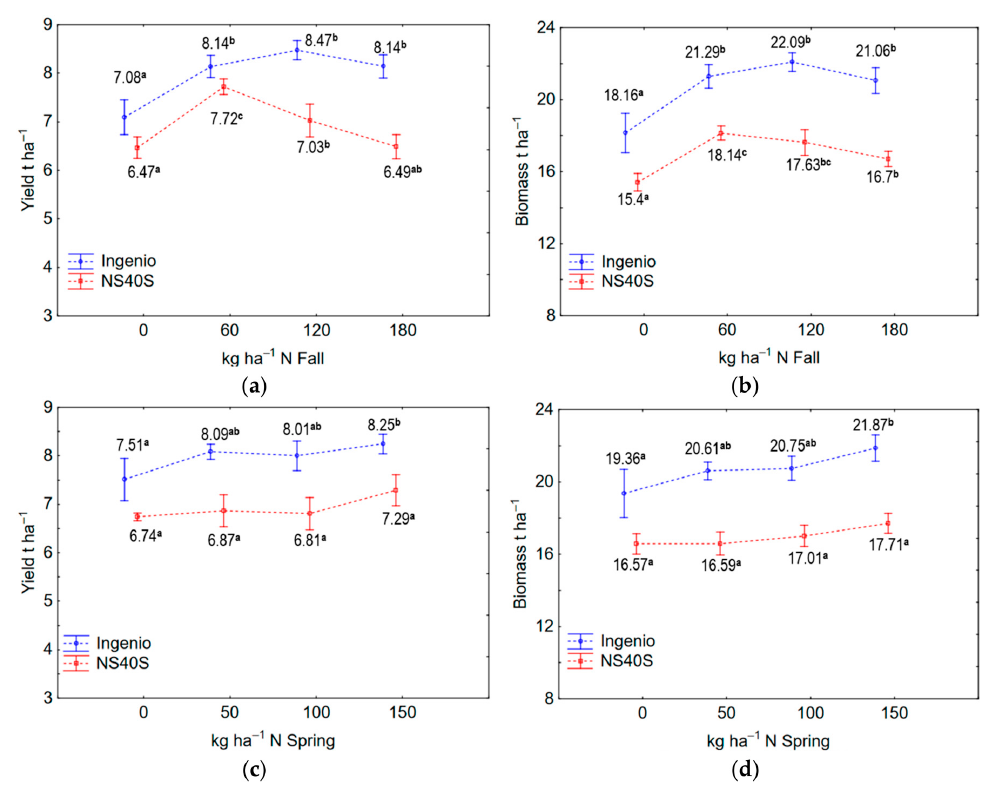
Figure 8. Effects of fall N fertilizer application ( a , b ) and spring N fertilizer application ( c , d ) on grain yield and biomass of Ingenio, NS40S, Futura, and Pobeda wheat varieties for 2020 growing season. The letters on the graph represent different classes obtained by ANOVA with p = 0.05 level of